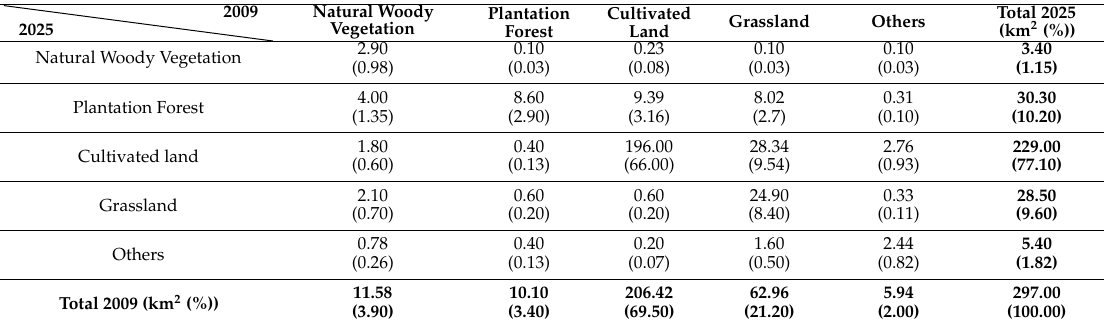
Table 8. Land-use conversion matrix (2009–2025): total area of conversion between land-cover types in km 2 and percentages (in